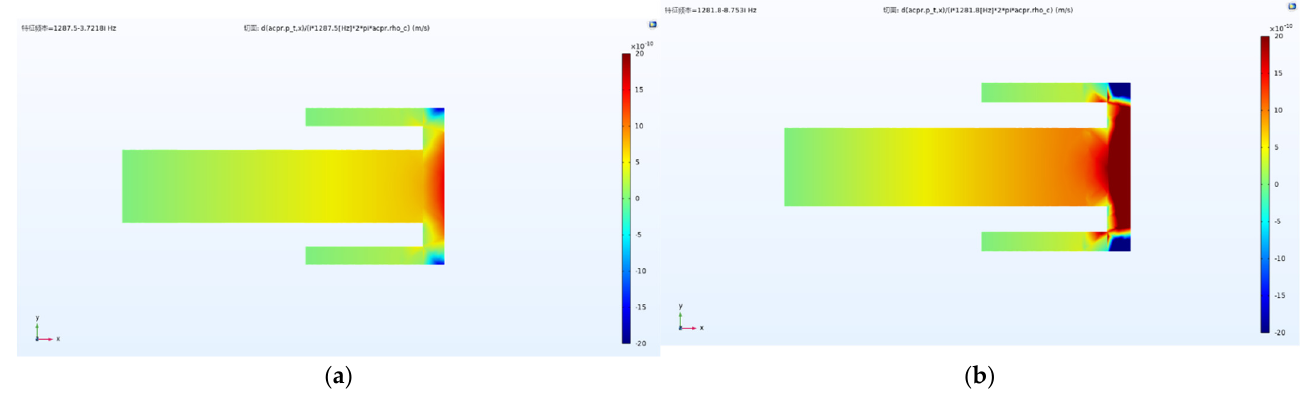
Figure 6. Velocity pulsation distribution in injector. ( a ) Scheme 1. ( b ) Scheme